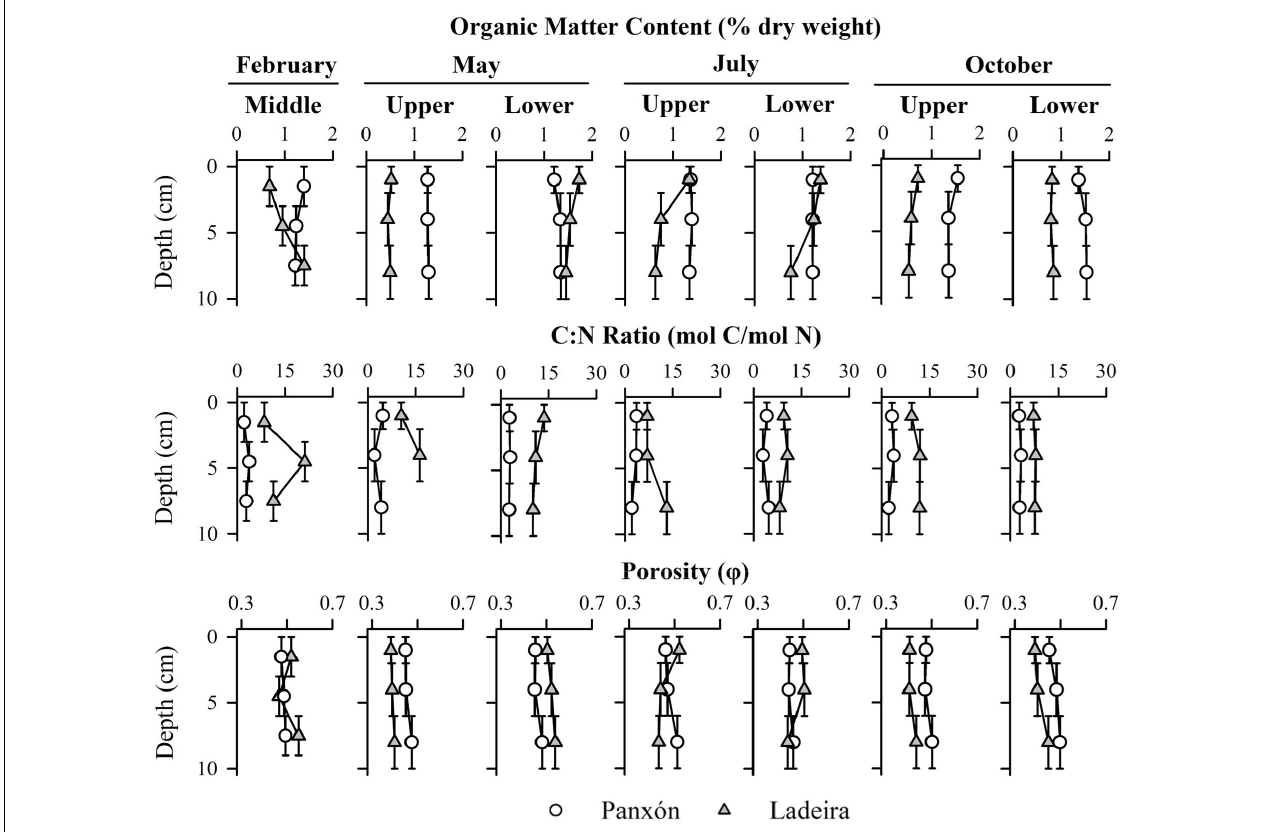
FIGURE 3 | Vertical sediment profiles of organic matter (% dry weight), C:N molar ratio and porosity ( φ ) of each beach and survey at the middle station in February and at the lower and higher sampling stations in the remaining surveys. The vertical error bars represent the length of the sliced sediment samples.